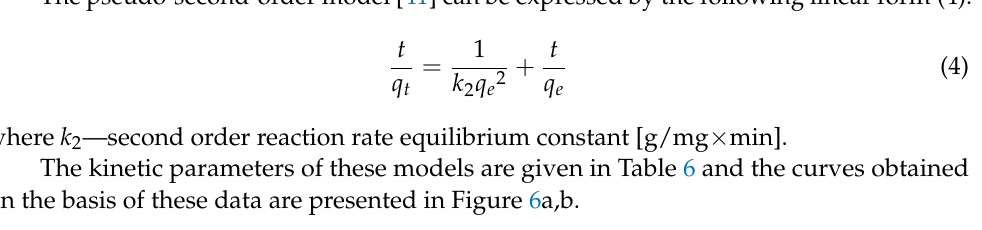
Table 6. Adsorption kinetics parameters for the adsorption of methyl red sodium salt on the biocar- bons